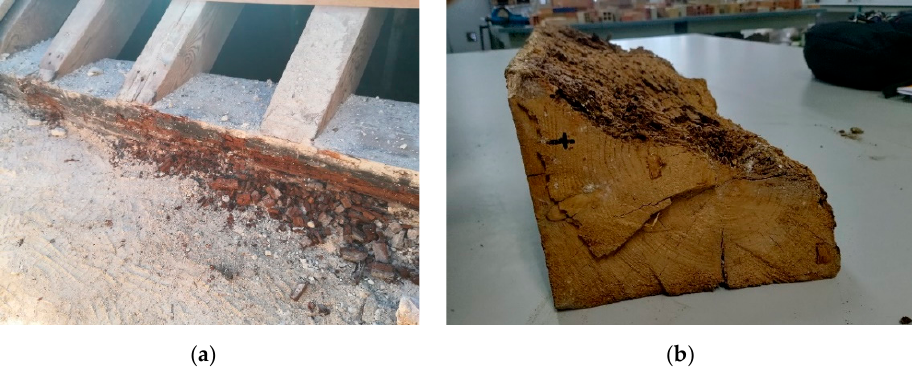
Figure 19. State of the wall plates: ( a ) the hidden face is completely decayed due to rot; ( b ) a section of the piece is extracted and analysed. of the piece is extracted and